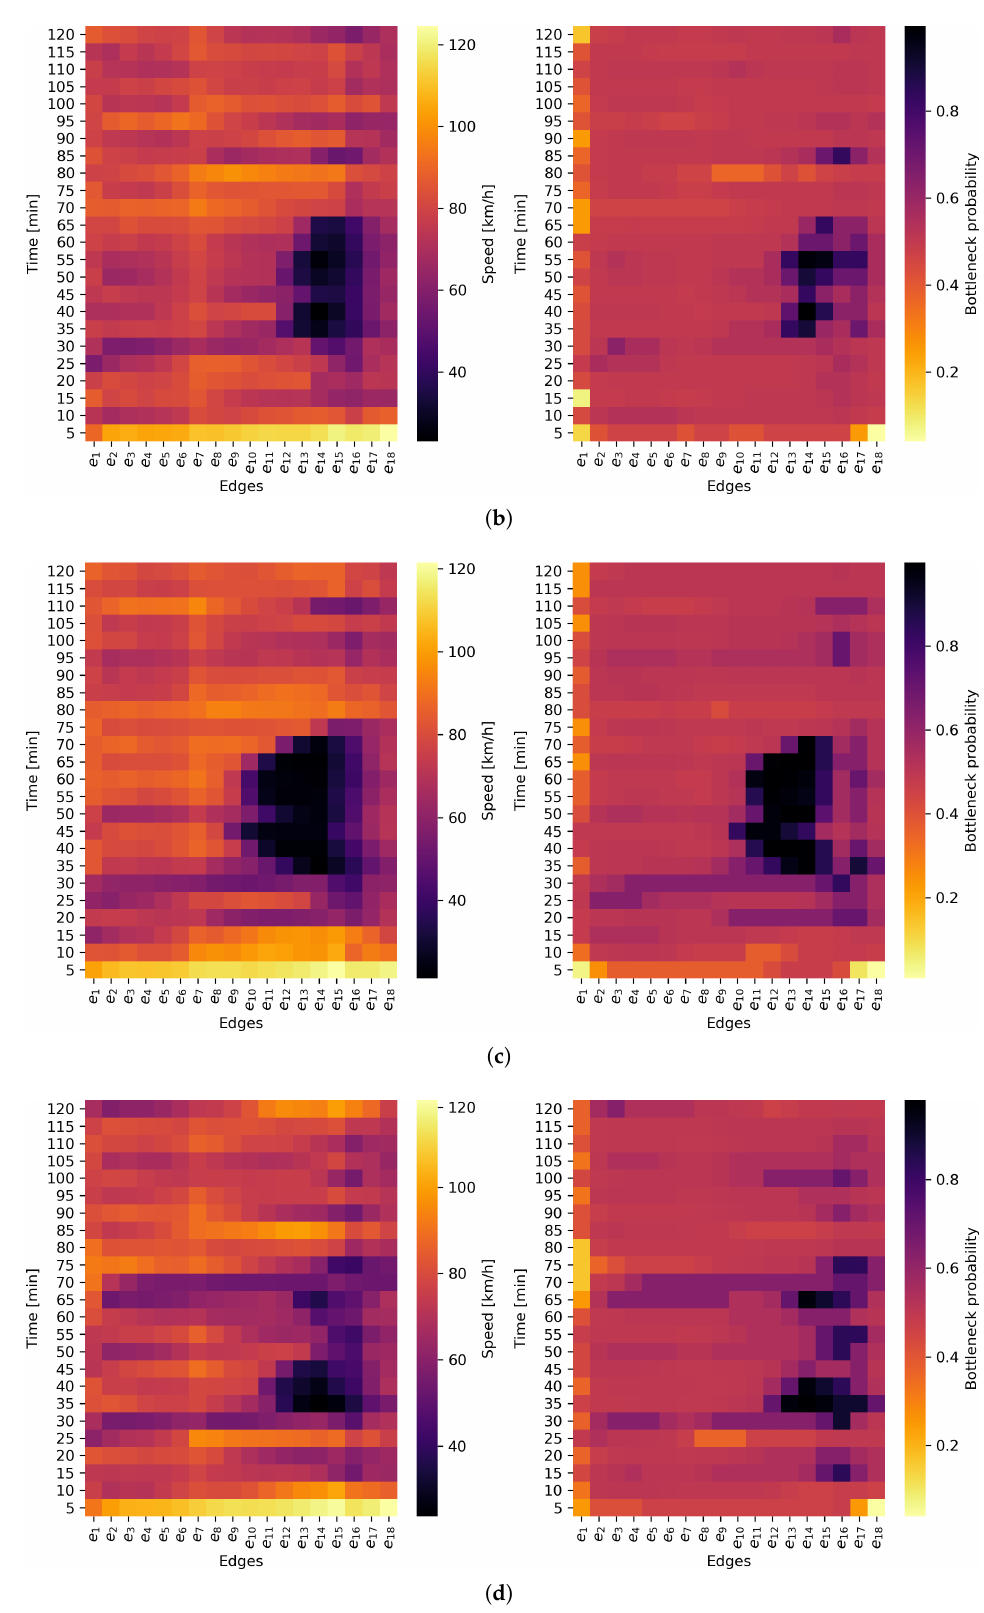
Figure 7. Results of the comparison between absolute harmonic speed measurements ( left column ) and proposed bottleneck probability estimation method ( right column ). ( a ) Scenario 1—collision site; ( b ) Scenario 2—recurring short bottleneck; ( c ) Scenario 3—recurring long bottleneck; ( d ) Scenario 4—moving